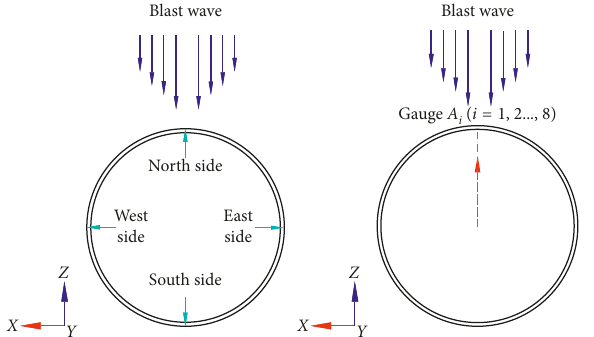
Figure 19: Layout of strain measuring gauges.